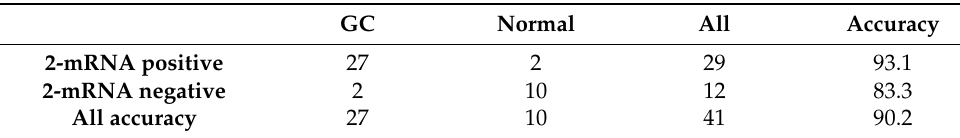
Table 3. Accuracy of early